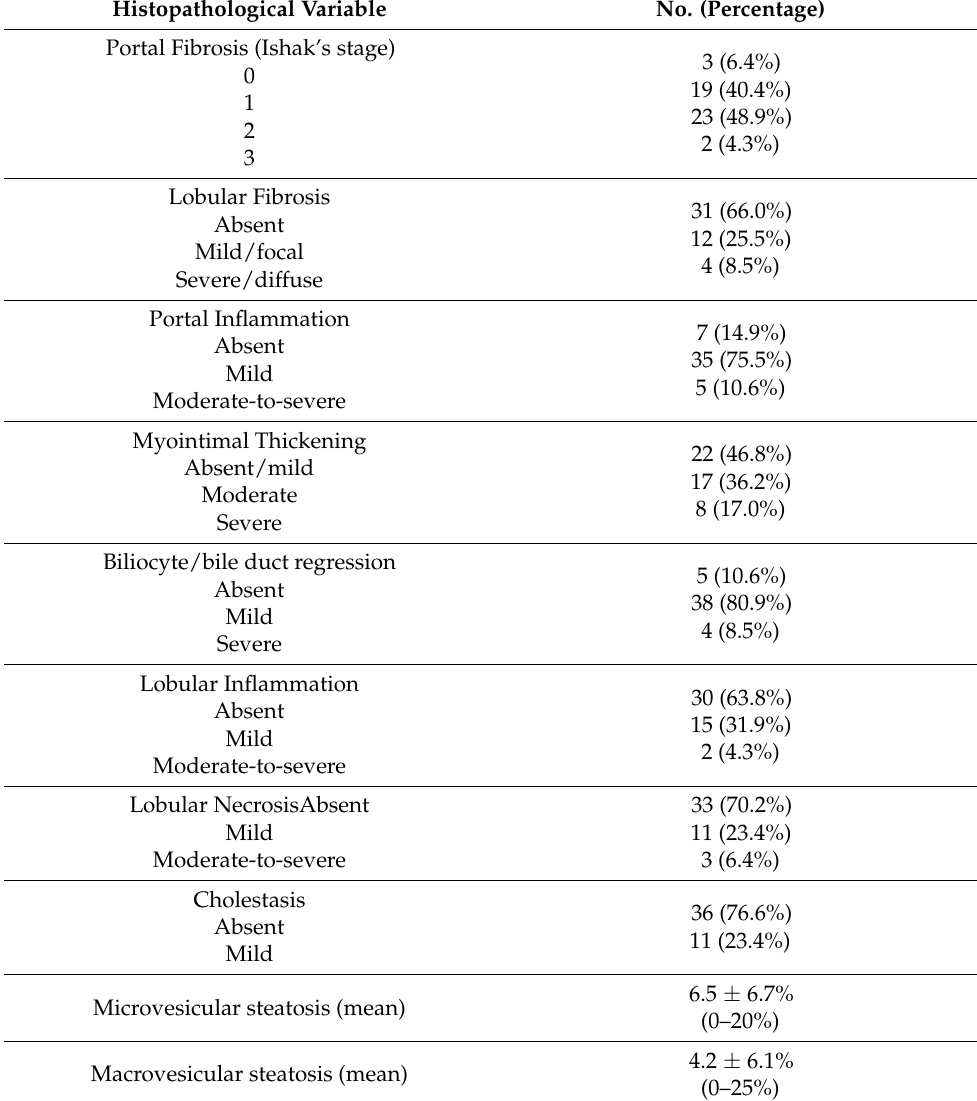
Table 1. Histopathological features of the 47 liver grafts